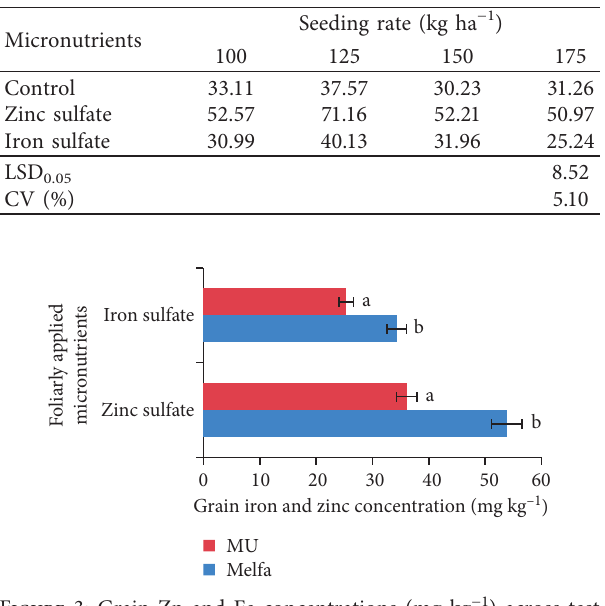
Figure 3: Grain Zn and Fe concentrations (mg kg − 1 ) across test locations. Bars designated by different letters are statistically dif- ferent from each other.